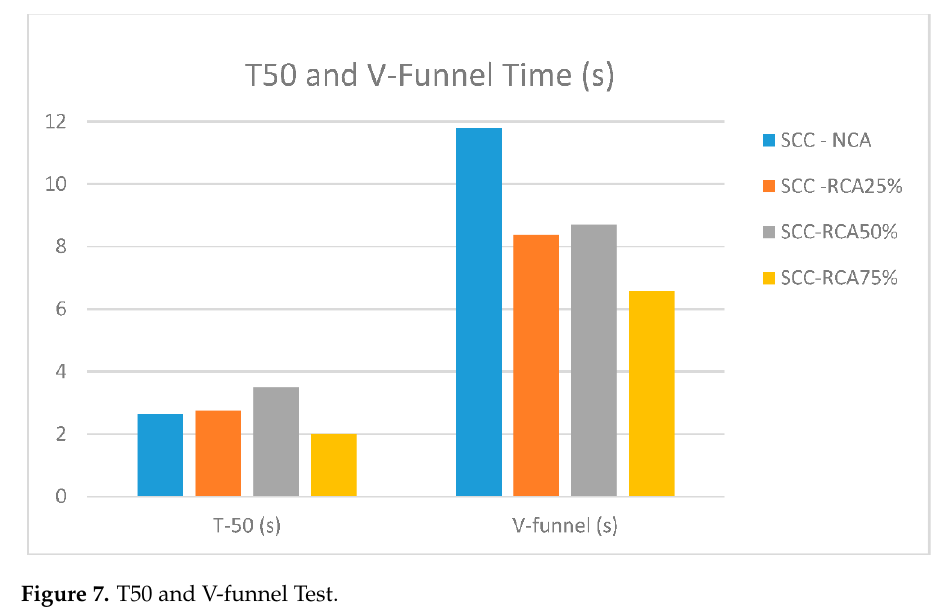
Figure 7. T50 and V-funnel Test.